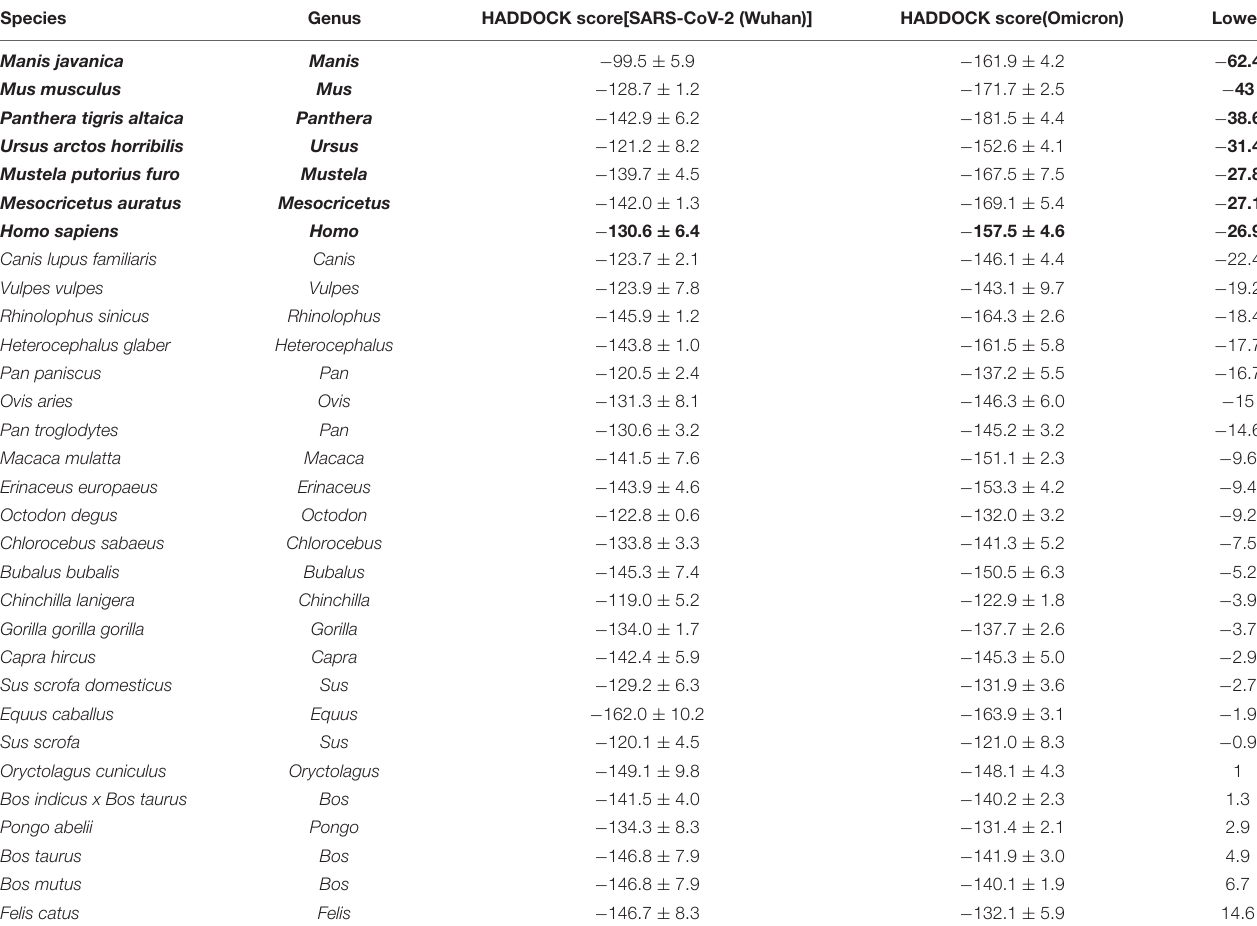
TABLE 2 | The HADDOCK scores of complexes formed by viral spike protein and the ACE2 proteins of 31 species. Species Genus HADDOCK score[SARS-CoV-2